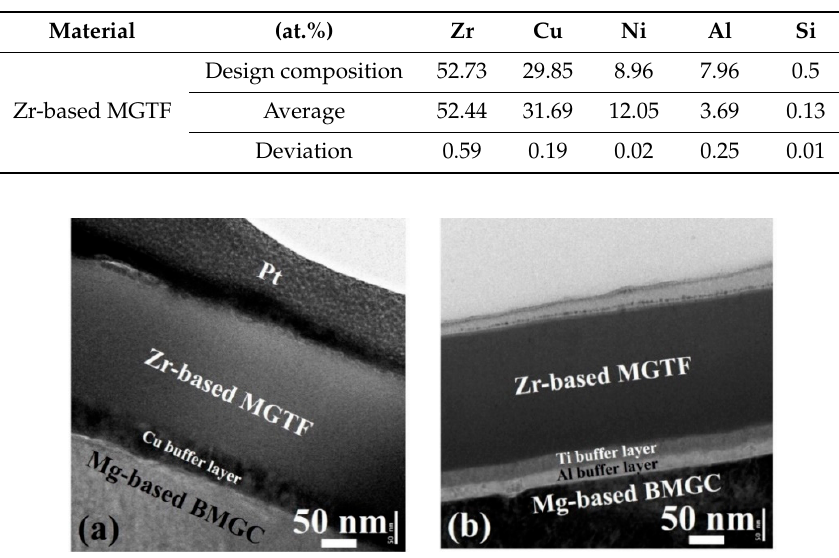
Figure 3. Cross-sectional TEM images of the Mg-based BMGC coated with a buffer layer and Zr-based metallic glass thin film (MGTF); ( a ) with Film A coating; ( b ) with Film B coating.